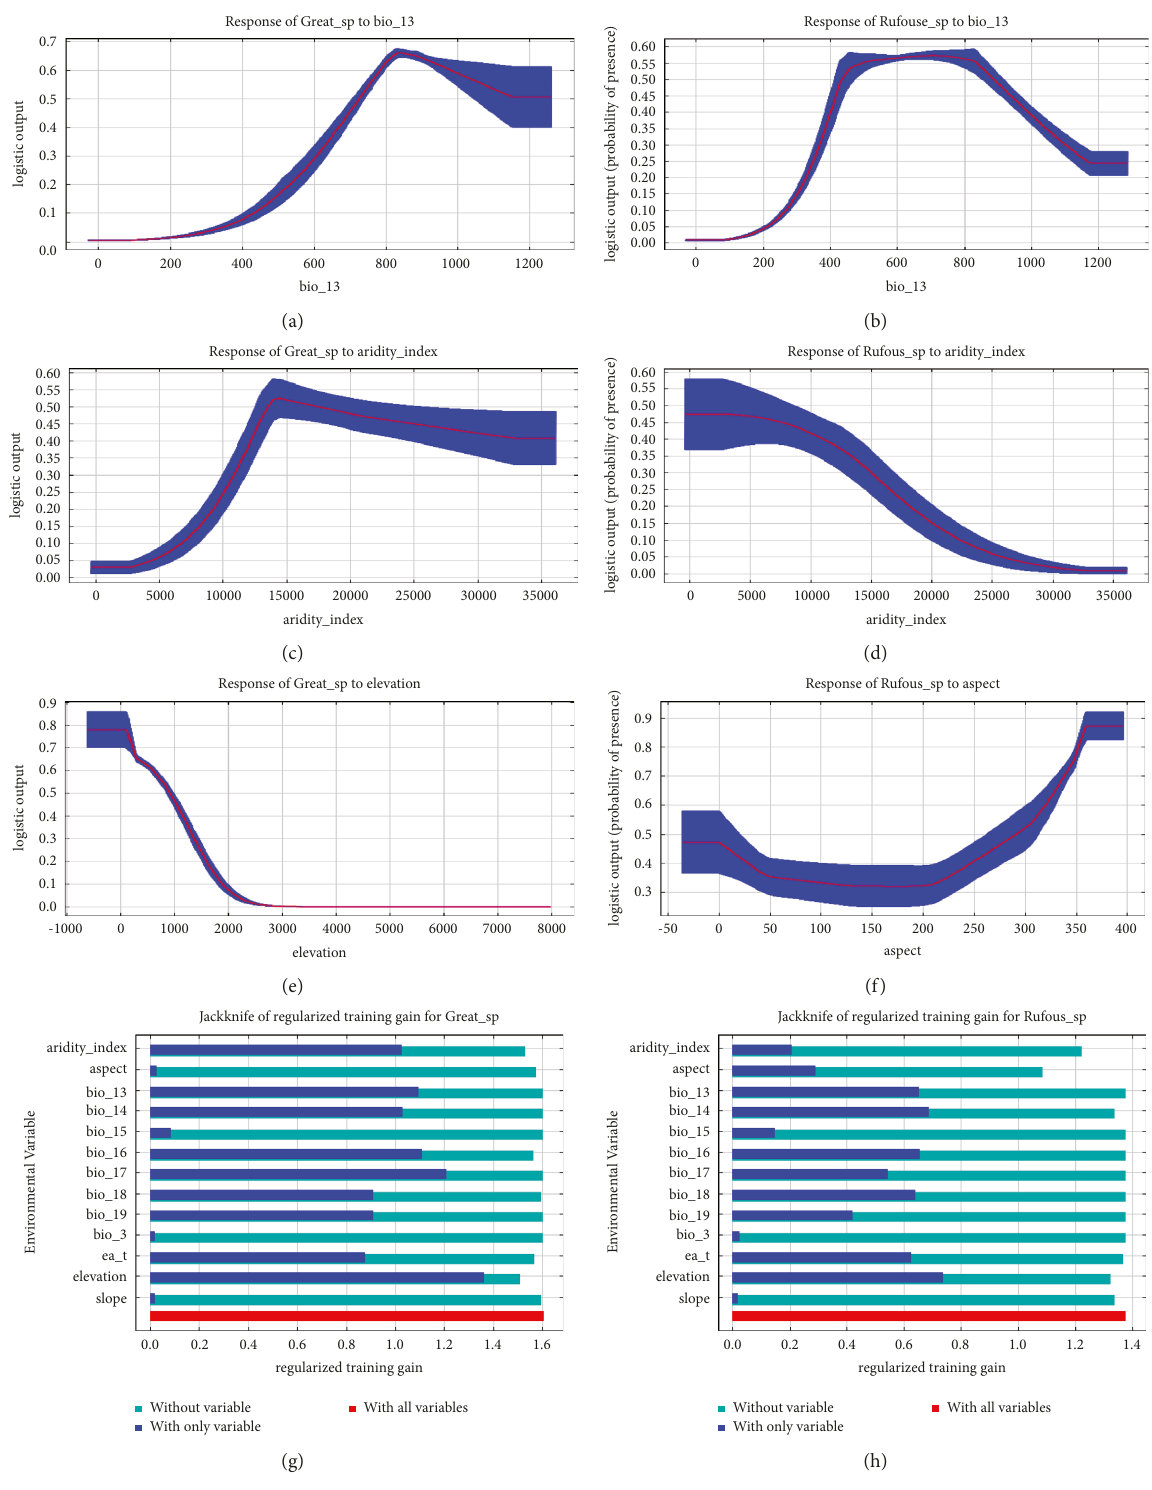
Figure 6: Response of GH and RNH to precipitation of wettest month (BIO_13), aridity index, and Finally, the testing average AUC for 100 replicates runs of (Figures 6(g) and 6(h)). The most influential environmental the model was AUC � 0.915 with the standard deviation 0.023 variable that decreases the gain is aspect. This indicates for the great hornbill and incase of rufous-necked hornbill aspect is more effective in defining the model than any was AUC � 0.872 with the standard deviation 0.060 (Figure 7). other variable.